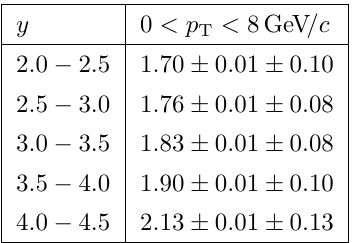
Table 13 . Cross-section ratios between 13 TeV and 5 TeV measurements for prompt J/ψ mesons as a function of y with p T < 8 GeV/ c . The first uncertainty is statistical and the second is systematic.